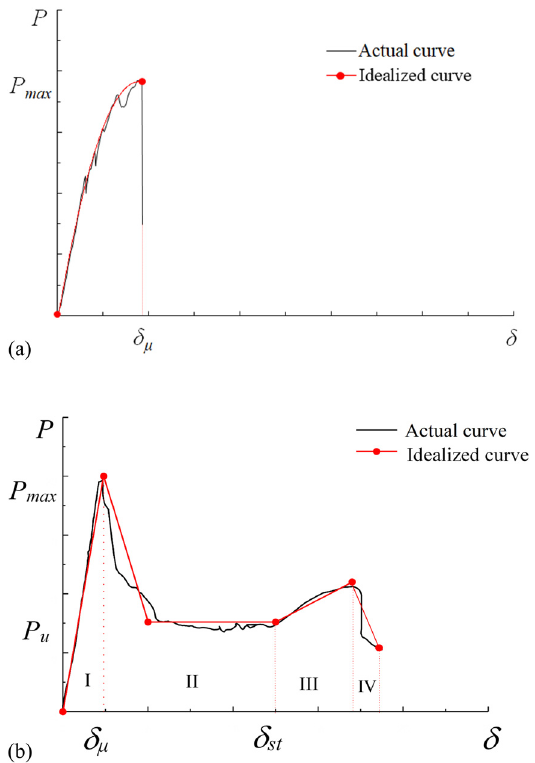
Figure 4: Typical load – displacement curves. ( a ) Bare syntactic foam panels. ( b ) FRP – syntactic foam sandwich panels.